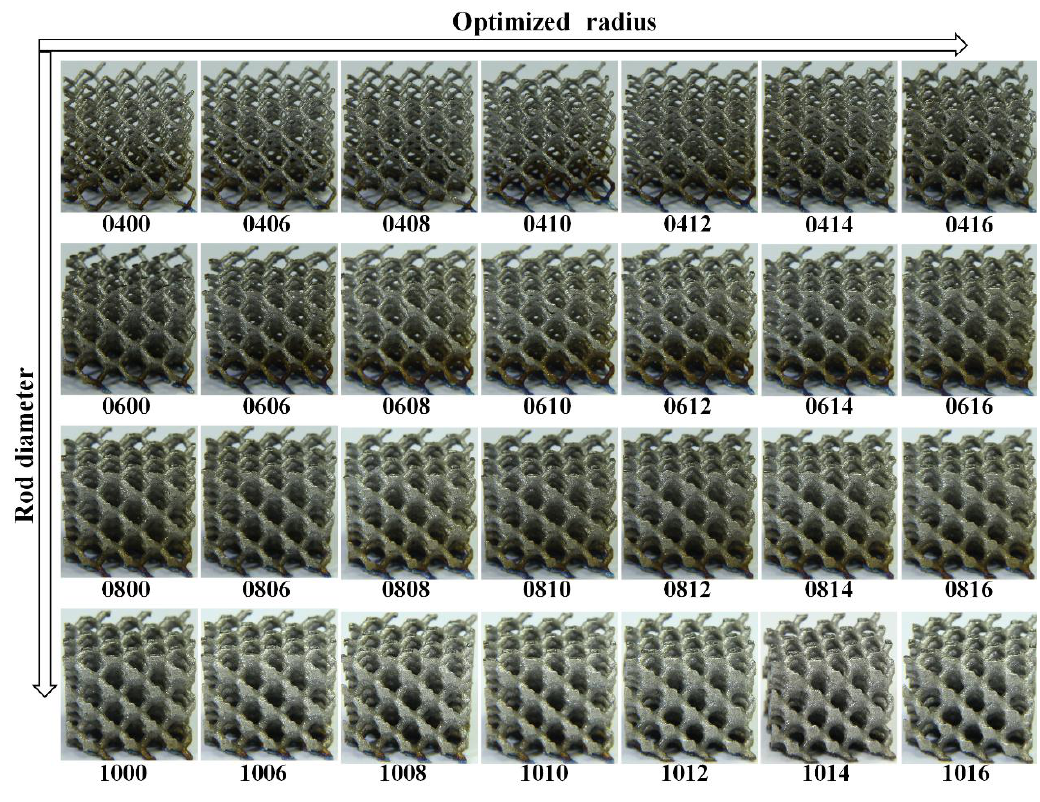
Figure 4. The formed samples by selective laser melting with a dimension of 16.5 × 16.5 × 16.5 mm 3 (where ‘10′ denotes D = 1.0 mm, ‘16′ denotes R = 1.6 mm, and other numbers (for example, ‘1008′) are similar).